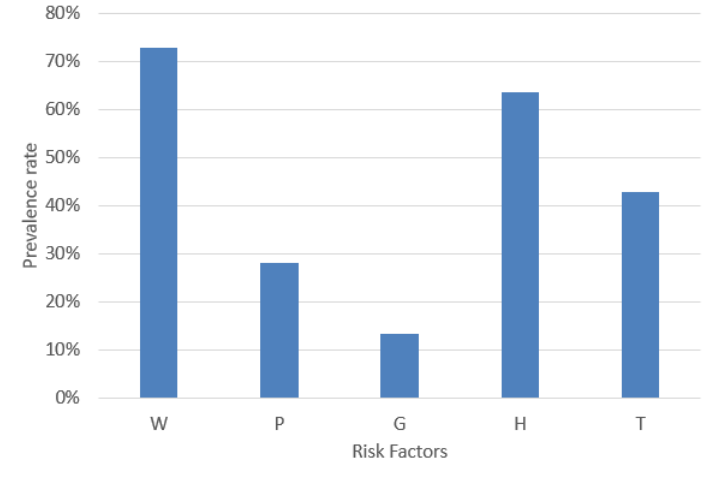
Figure 5. Prevalence rate of the MetS risk